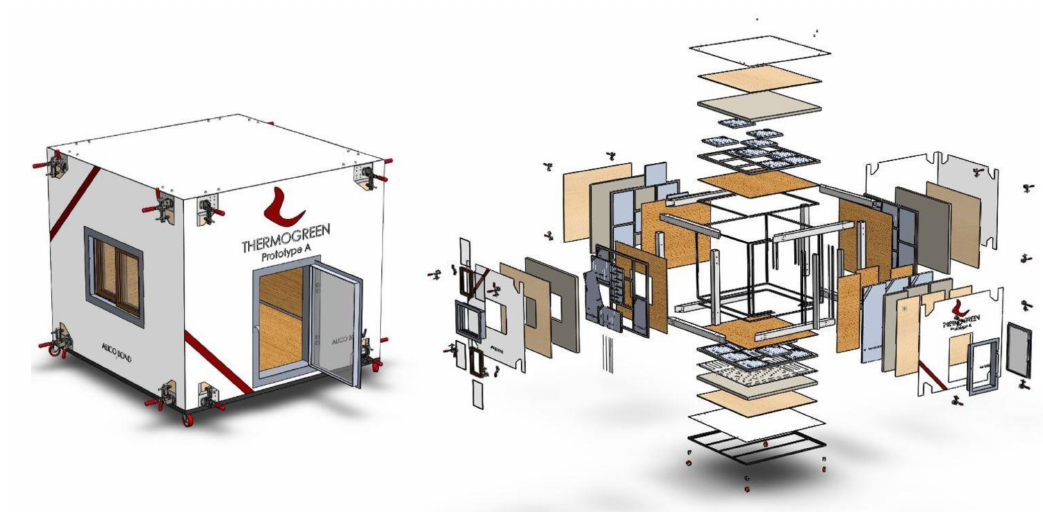
Figure 22. Proposed prototype design: final assembly and exploded view.